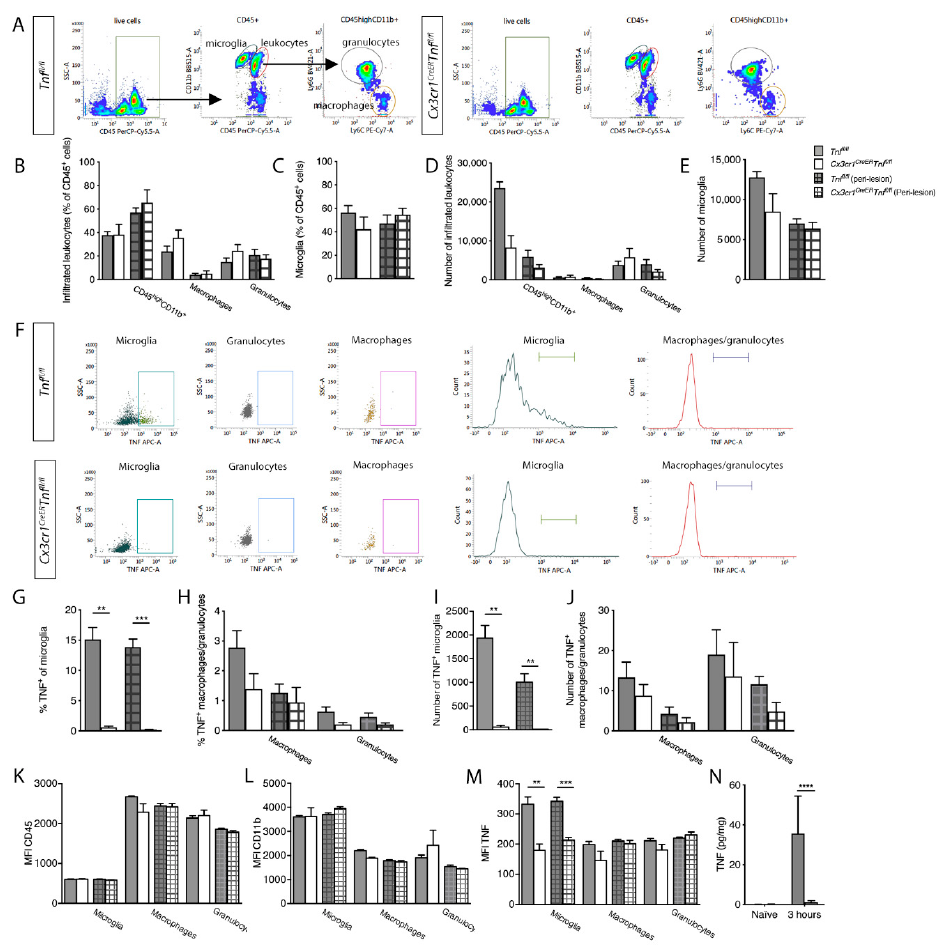
Figure 3. Analysis of spinal cord microglial/leukocyte populations after SCI in Tnf fl/fl and Cx3cr1 CreER Tnf fl/fl mice. ( A ) Dot plots showing gating strategies for CD45 + cells, CD11b + CD45 high leukocytes, CD11b + CD45 dim microglia, CD11b + CD45 high Ly6C + Ly6G - macrophages, and CD11b + CD45 high Ly6C + Ly6G + granulocytes in Tnf fl/fl and Cx3cr1 CreER Tnf fl/fl mice 3h after SCI. ( B – E ) Leukocyte and microglial populations were comparable between Tnf fl/fl and Cx3cr1 CreER Tnf fl/fl mice 3 h after SCI. ( F ) Dot plots and histograms of TNF expression in microglia, macrophages, and granulocytes isolated from Tnf fl/fl and Cx3cr1 CreER Tnf fl/fl mice 3h after SCI. ( G – J ) The percentage ( G ) and total number ( I ) of TNF + microglia were significantly reduced in Cx3cr1 CreER Tnf fl/fl compared Tnf fl/fl mice 3h after SCI, whereas TNF expression on leukocytes ( H , J ) was comparable between Tnf fl/fl and Cx3cr1 CreER Tnf fl/fl mice 3h after SCI. ( K , L ) No change in MFI for CD45 ( K ) or CD11b ( L ) was observed. ( M ) MFI for TNF was significantly decreased in microglia derived from Cx3cr1 CreER Tnf fl/fl mice compared to those from Tnf fl/fl mice. MFI for TNF in macrophages and granulocytes was comparable between the two genotypes. Results are expressed as mean ± SEM. ** p < 0.01, *** p < 0.001, Student’s t -test. Open bars represent the lesion site, checkered bars represent the peri-lesion site, n = 3–6/group. ( N ) TNF (two-way ANOVA; SCI p = 0.0003, F 1,17 = 20.79; genotype: p = 0.0005, F 1,17 = 18.70; interaction: p = 0.0004, F 1,17 = 18.81) protein levels were quantified by electrochemiluminescence technology in naïve conditions and 3 h after SCI in Tnf fl/fl and Cx3cr1 CreER Tnf fl/fl mice. For each protein, results are expressed as mean ± SEM, n = 5–6 mice/group. Sidak’s post hoc **** p < 0.0001.